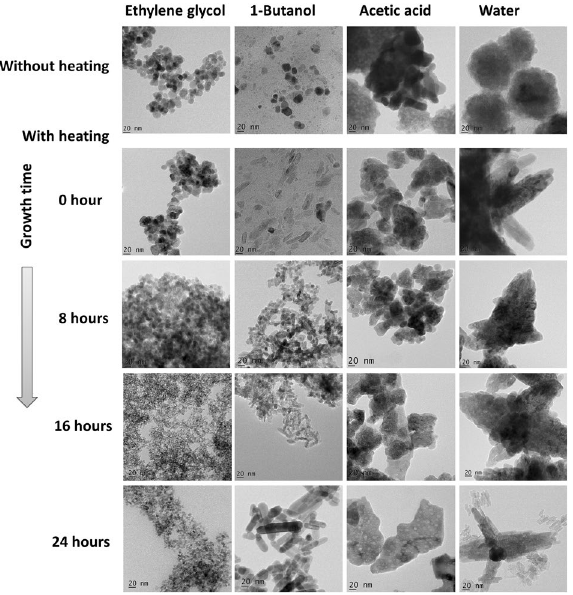
Figure 1. TEM image of ZnO nanostructures synthesized in ( a ) ethylene glycol ( b ) 1-butanol ( c ) acetic acid and ( d )